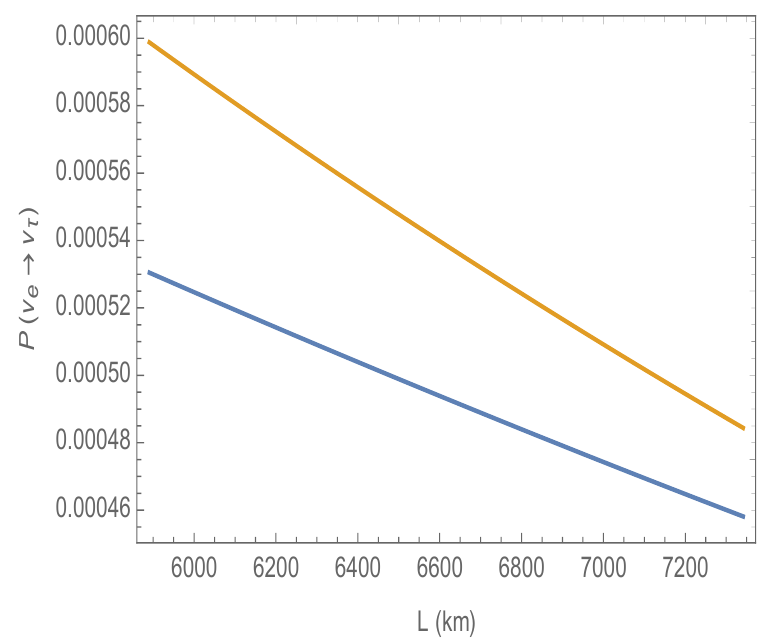
Figure 2 . Probability ν e → ν τ in the presence of DM effects within the 3+1 scheme versus the size of the traversed chord. We have assumed that both in the solar system and in the production site, the dark matter density is relatively large with V α (cid:29) ∆ m 2 / (2 E ν ) but still V α (cid:28) ∆ M 2 / (2 E ν ) so 31 the effective mixing between active and sterile neutrinos remain equal to the values in the vacuum but the effective mixings between active neutrinos become suppressed. We have taken | U τ 4 | 2 = 0 . 1 and | U e 4 | 2 = 0 . 02 . The rest of the parameters are as described in the caption of figure 1. The orange and blue lines respectively correspond to the antineutrino and neutrino